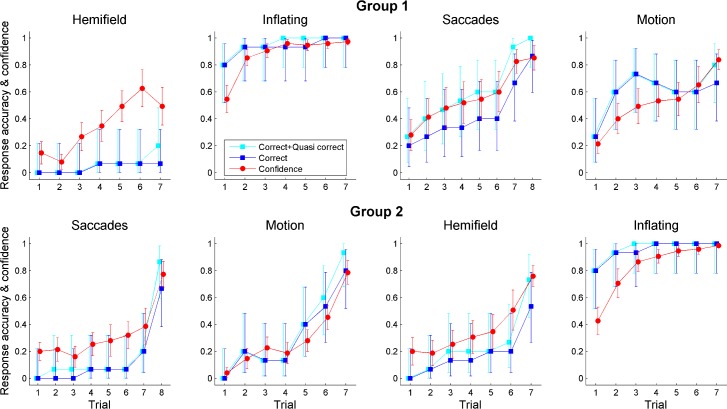
Time-course of task performance over successive trials.The blue and cyan data-points represent the objective performance (accuracy, correct and quasi-correct responses respectively) while the red data-points represent the subjective performance (confidence, normalized). The left-to-right order of conditions represents the real temporal sequence of presentation in the two groups (Conditions’ sequence for Group 1: “Hemifield → Inflating → Saccades → Motion”; for Group 2: “Saccades → Motion → Hemifield → Inflating”). Error bars represent 99% confidence intervals of the means.